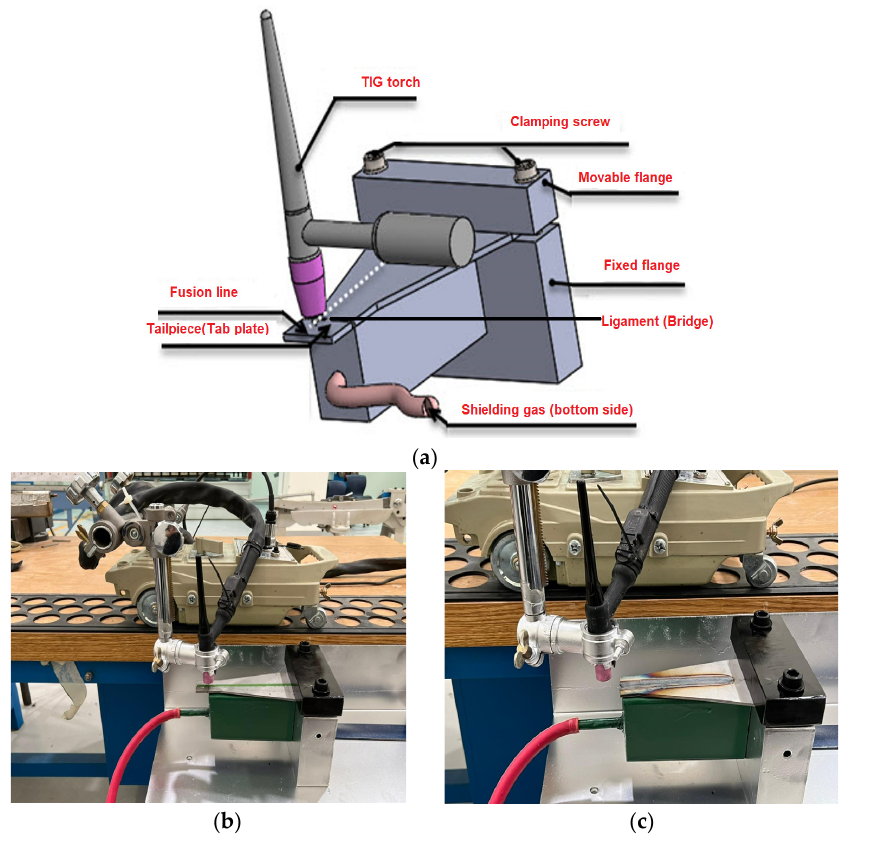
Figure 2. Test setup sketch ( a ), specimen before welding ( b ) and specimen after welding ( c ). Figure 3. Liquid penetrant kit used after welding ( a ) on the weld line ( b ).